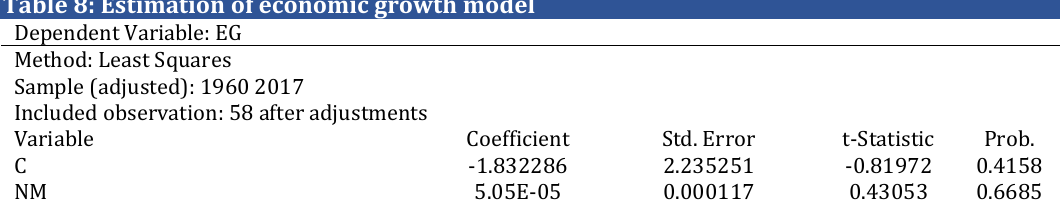
Table 8: Estimation of economic growth model